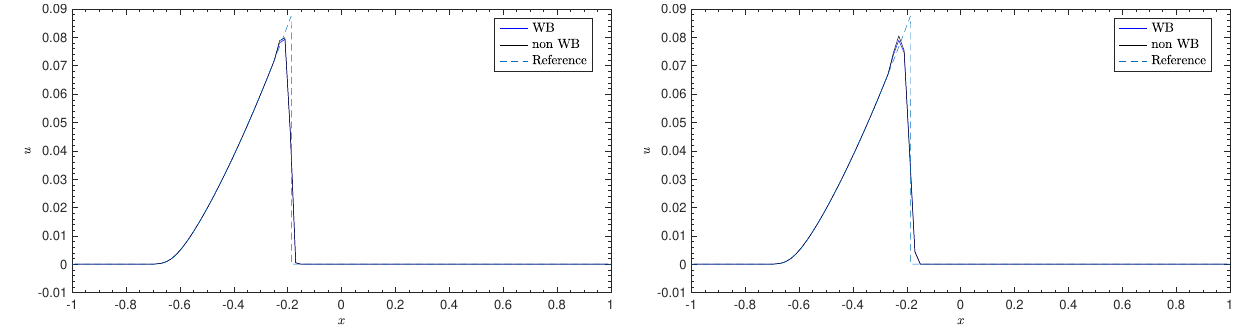
Figure 4. Computed variable u for the problem (47) (Burgers’ equation) with the second ( left ) and third ( right ) order well-balanced Runge–Kutta numerical methods at time t = 5 s. An uniform Cartesian mesh of N x = 100 elements has been